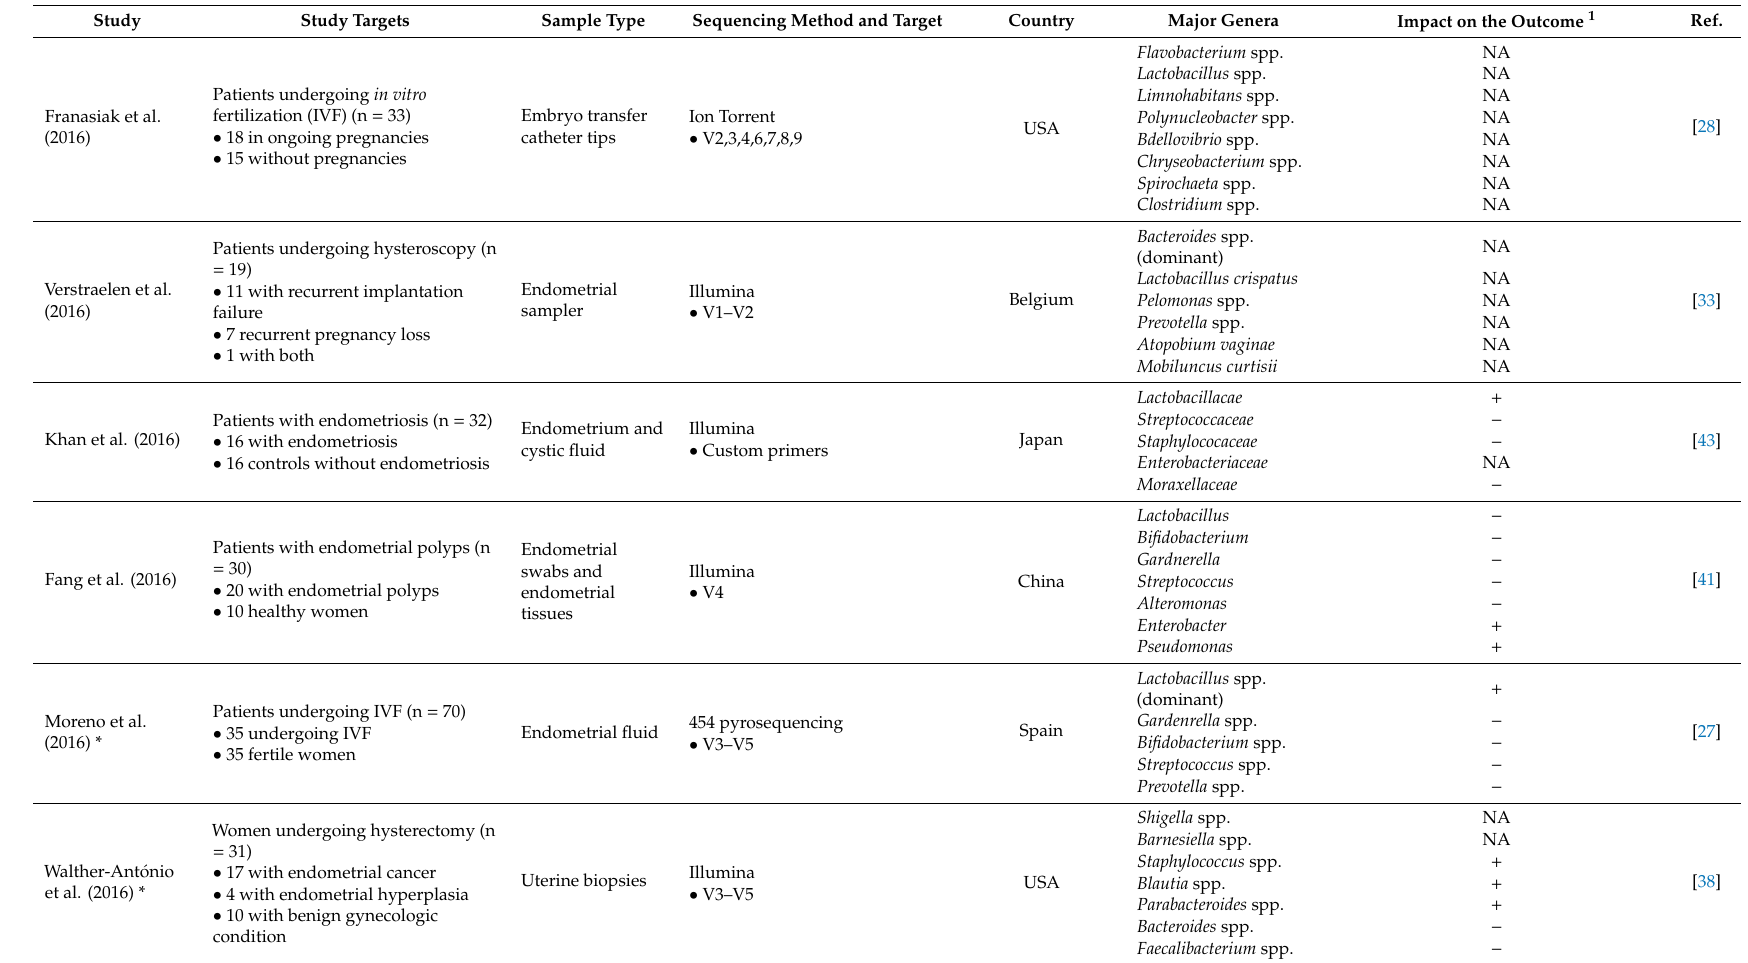
Table 2. Metagenomic studies performed on endometrial